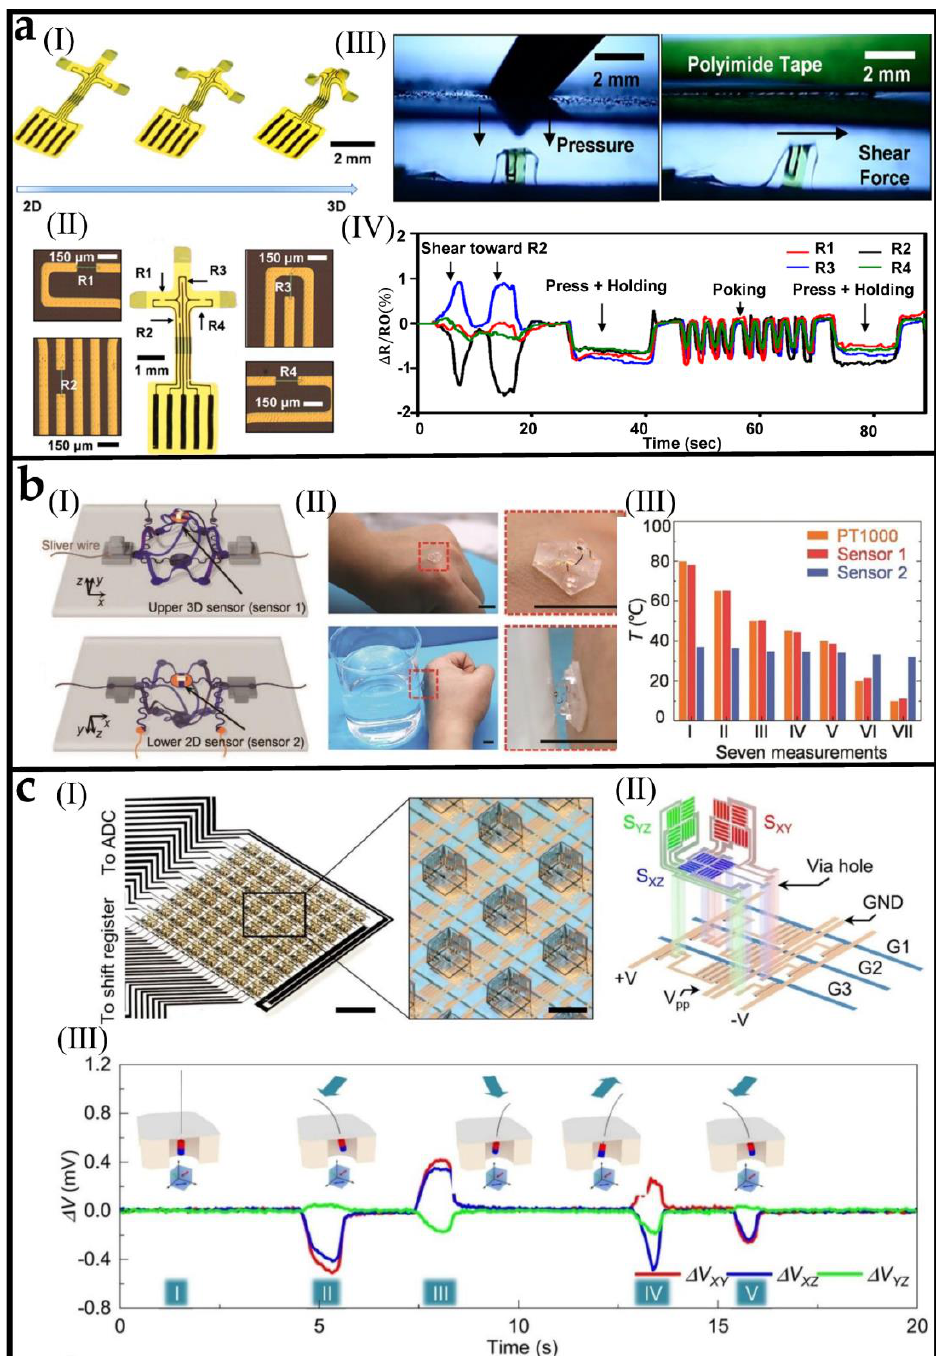
Figure 4. 3D assembled multifunctional sensors ( a ) ( I ) 3D microelectromechanical sensor molding diagram. ( II ) Optical microscope images of 2D precursor that have four piezoresistors. ( III ) Sensor responses to normal force (left) and shear force (right). ( IV ) The sensor recorded response to shear force and normal pressure. Reprinted with permission from [105]. Copyright 2019 American Chemical Society. ( b ) ( I ) Schematic diagram of 3D sensor composed of sensor 1 and sensor 2. ( II ) Optical image of water temperature measurement. ( III ) Electrical responses of the sensor to seven different water temperatures. Reprinted with permission from [106]. Copyright 2021 Wiley − VCH. ( c ) ( I ) Optical image of an IMOS device and the image of the pixel array in the device. ( II ) Exploded schematic and circuit diagram of a single pixel. ( III ) Single pixel response over time by bending the hair in different directions. Reprinted with permission from [107]. Copyright 2022 Nature Publishing